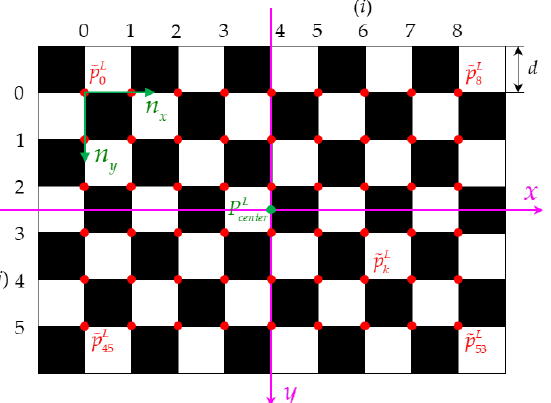
Figure 4. Schematic diagram of the position of each corner point in the LIDAR coordinate system. 2.